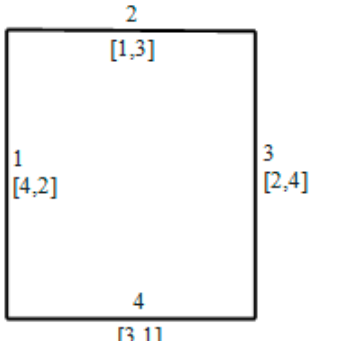
Figure 2. An example of assignment of IDs to segments (IDs between square brackets indicate the IDs of the connected